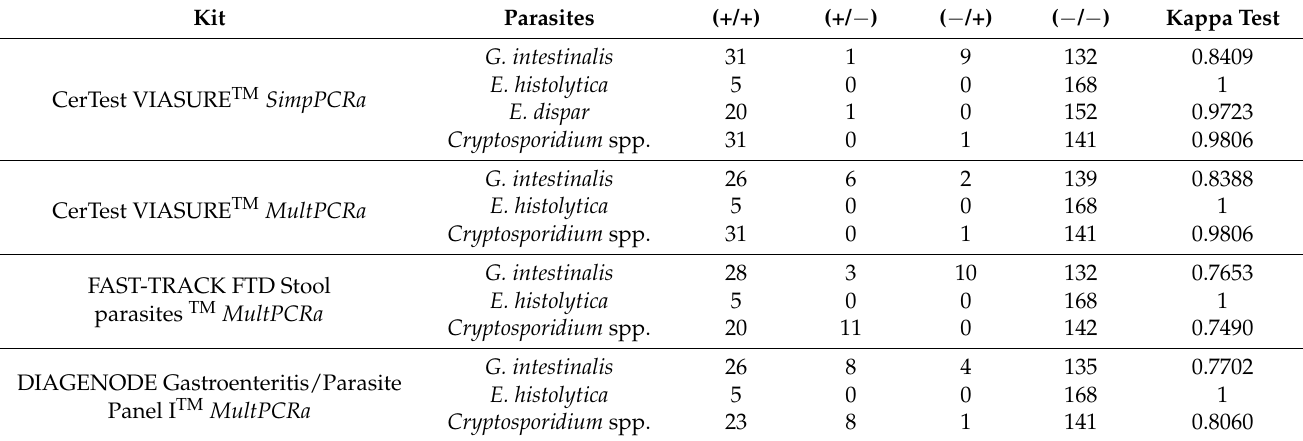
Table 3. Results of the commercial simplex and multiplex PCR assays compared to Dijon University Hospital in-house simplex PCR assays.